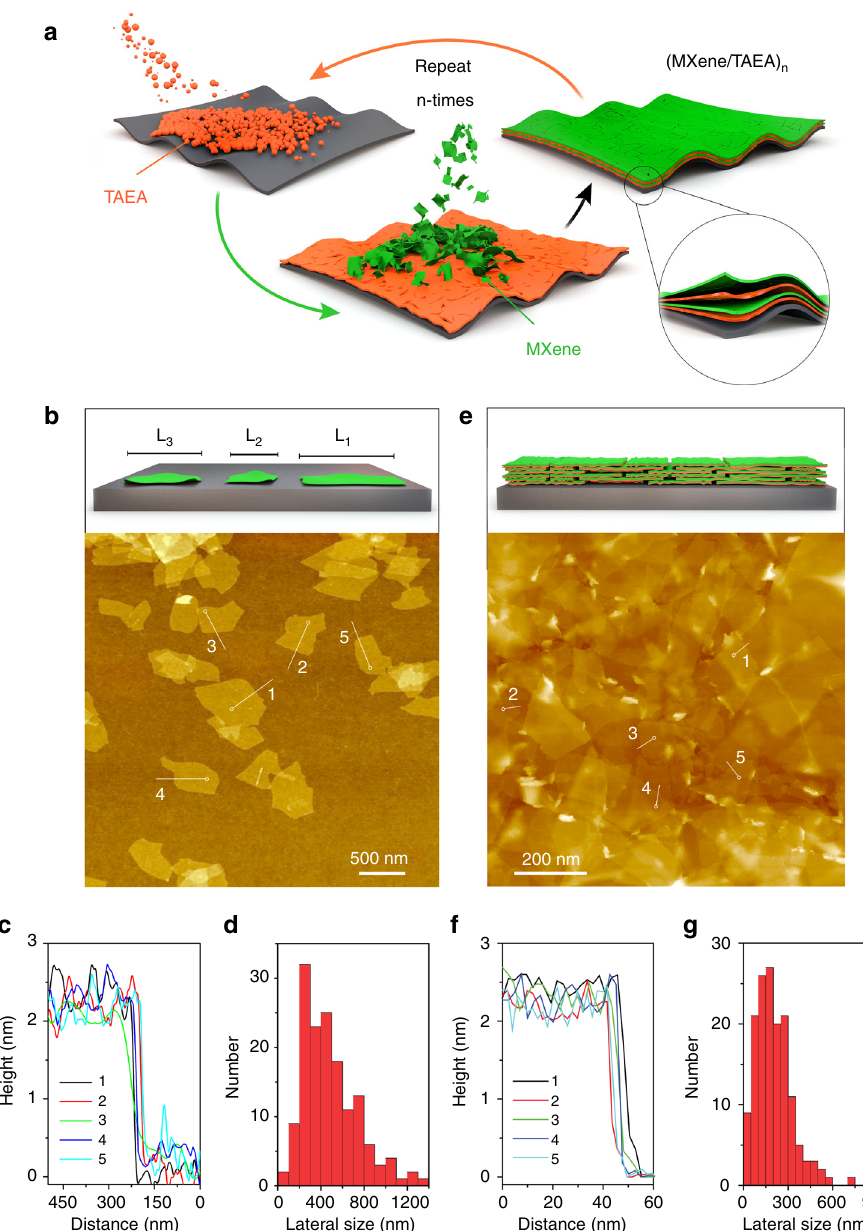
Fig. 1 Morphological characterization of Ti 3 C 2 T x MXene and (MXene/TAEA) n multilayers. a Schematic illustration of the LbL self-assembly of (MXene/ TAEA) n multilayer fi lms onto planar substrates. b AFM image of delaminated MXene fl akes on a silicon wafer, and c corresponding height pro fi les at